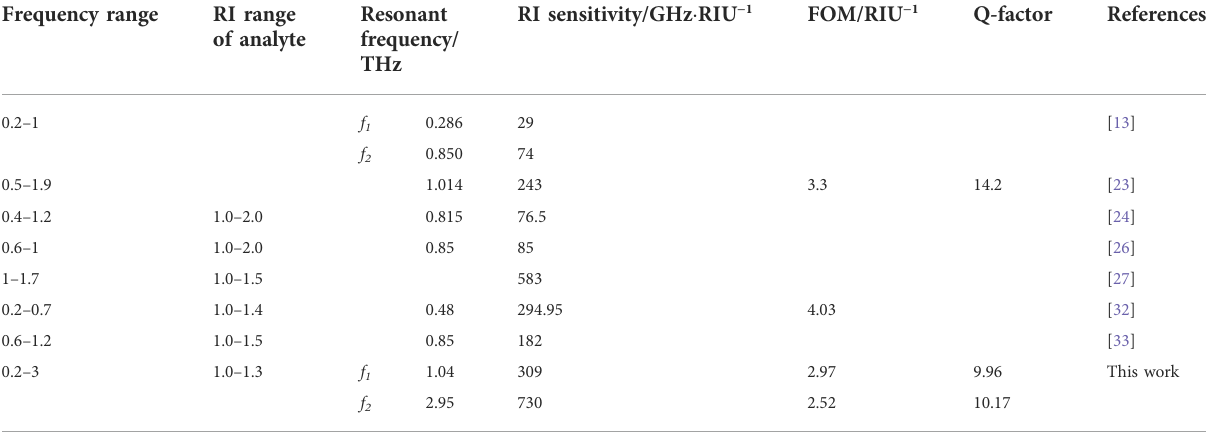
TABLE 2 Comparison of the sensing performance of the proposed sensor with previously reported analogues. Frequency